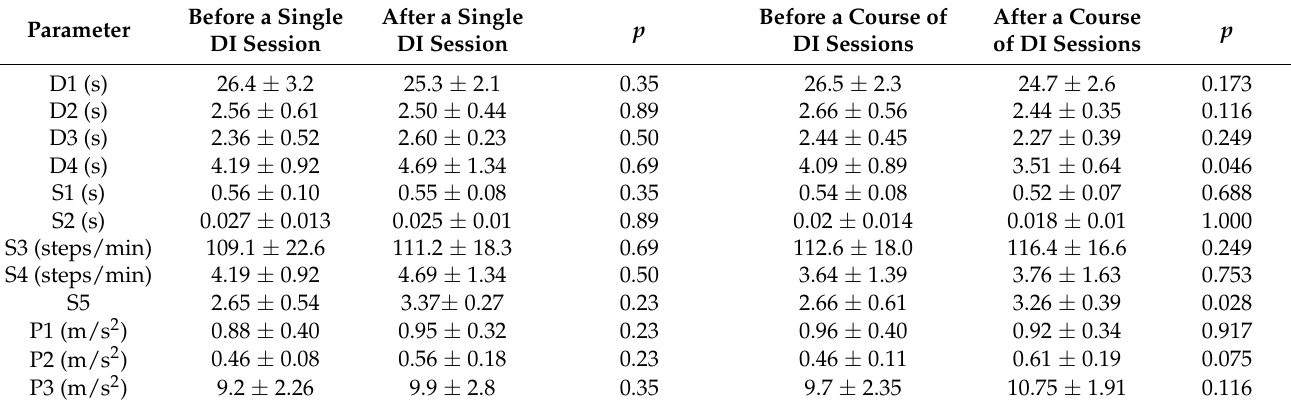
Table 2. Gait characteristics before and after a single DI session and after a course of DI sessions.